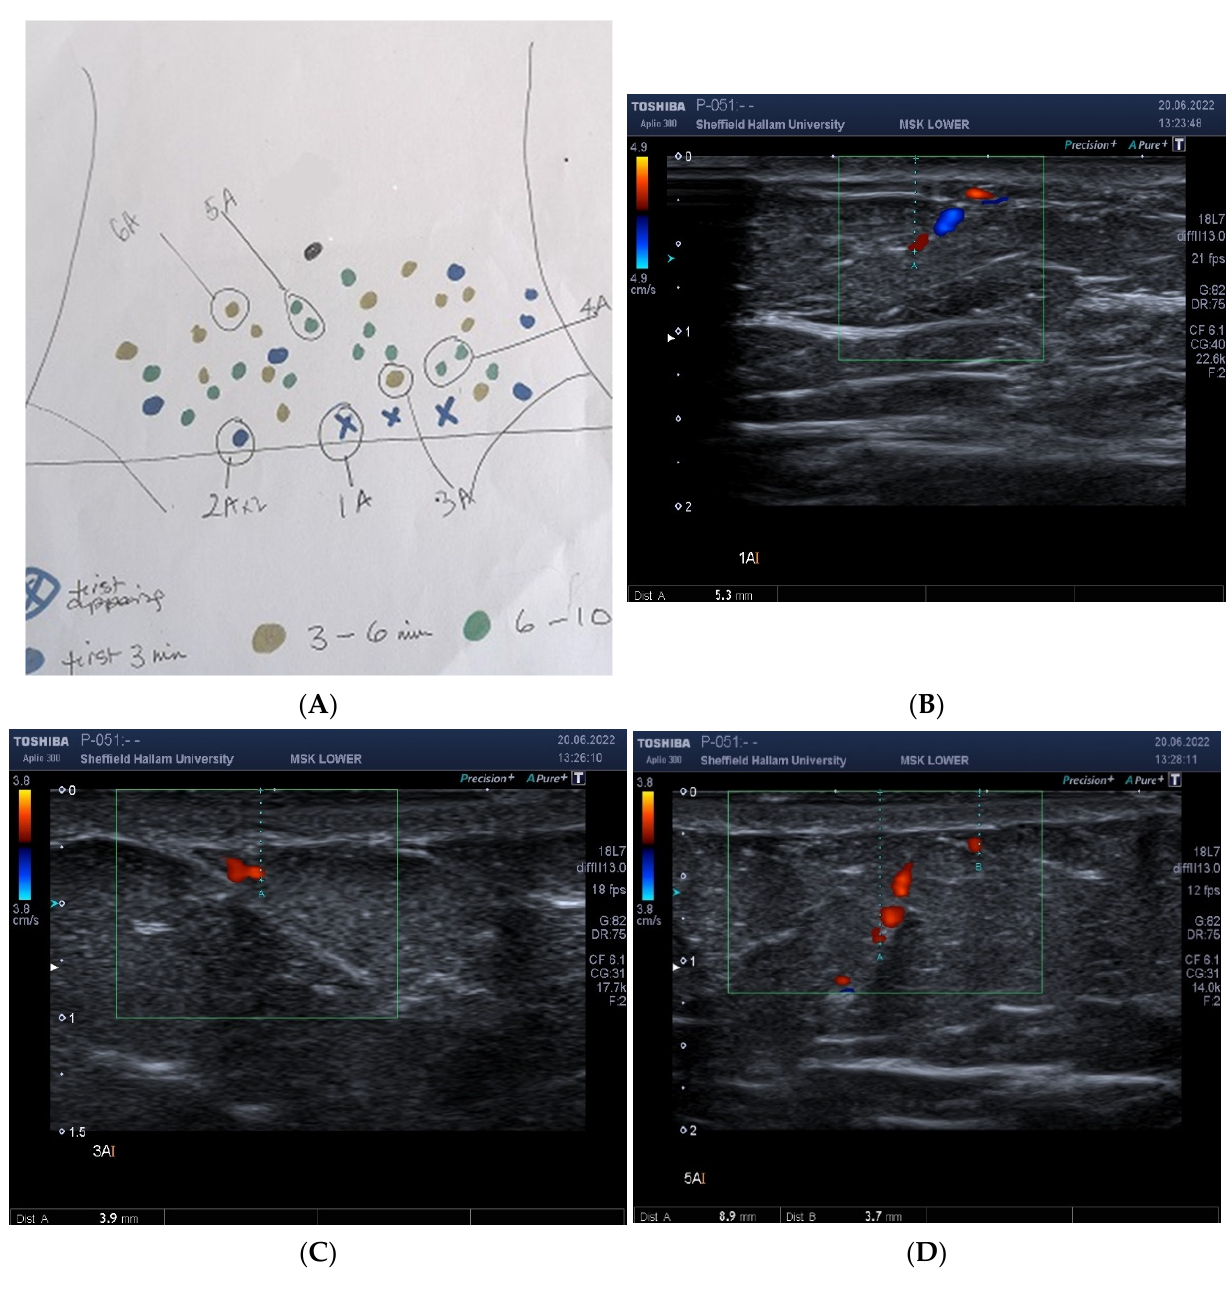
Figure 4. Correspondence of hot spot locations to guide position of Doppler ultrasound probe. Location of abdominal hotspots as they appeared in real-time, and mapped manually, as a sketch at the bedside, during 10 min video thermography ( A ). The labels were drawn to identify the sequence of appearance and to guide the sonographer for placement of the ultrasound probe. Blue marker (X) indicates first spot/s to appear. Blue circles, hot spot appearance within the first 3 min; gold, 3–6 min; green, 6–10 min, A. In this subject, three of the first hot spots appeared simultaneously and were marked accordingly by blue (X). Depth of vessel (5.3 mm) at hotspot (1A) measured using colour and power Doppler Ultrasound, ( B ). Vessel depth at 3 A 3.9 mm, ( C ). Depth of vessels at spots 5 A, 8.9 mm and 3.7 mm, respectively, ( D ).